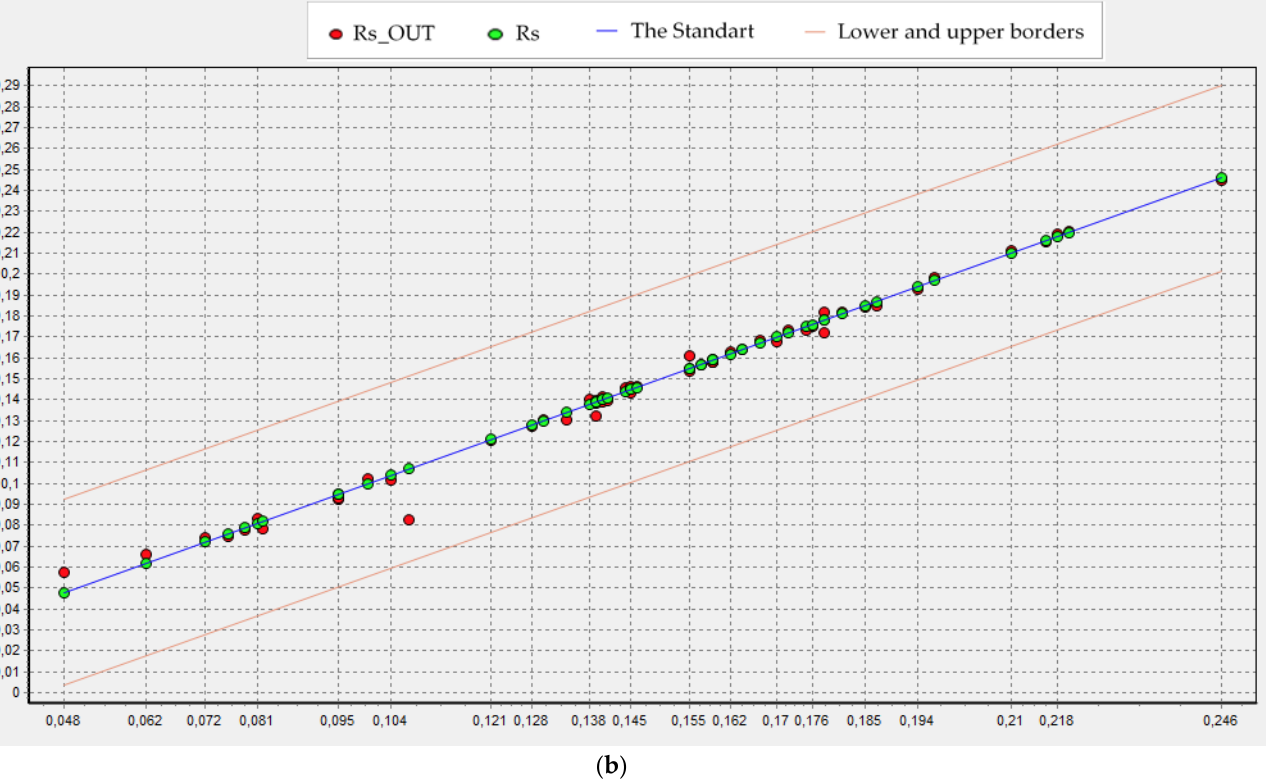
Figure 11. Scatter plot the training sample (logistic activation function), Built in Deductor Studio: ( a ) Return on sales R ps ; ( b ) Return on sales R s .